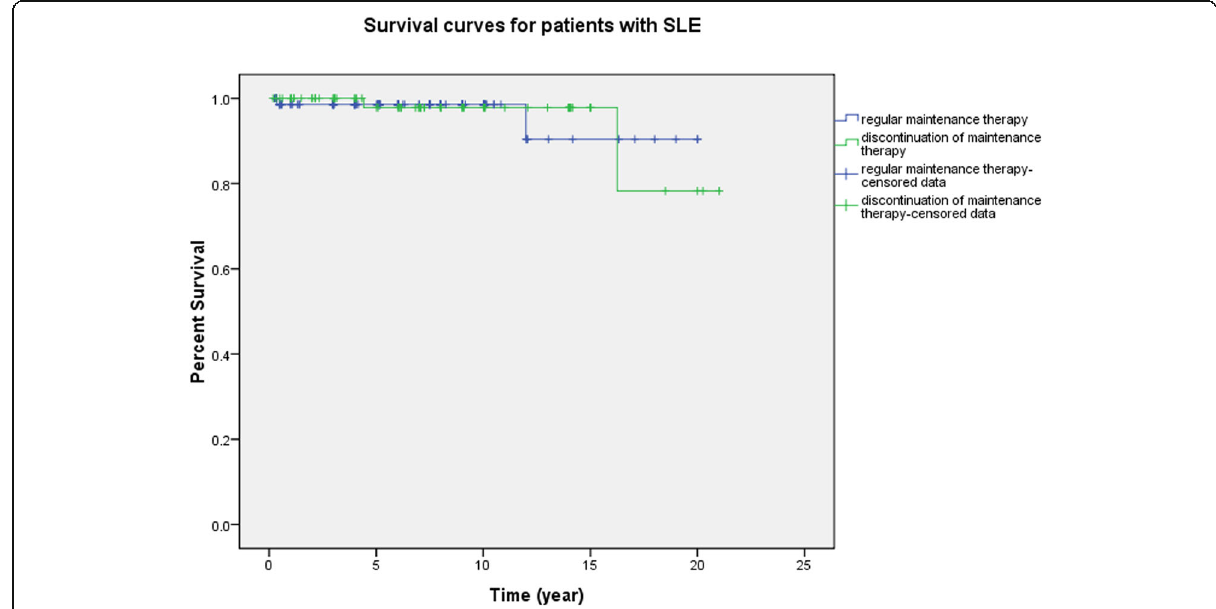
Fig. 1 Survival curves for patients with SLE who discontinued medicine maintenance therapy by themself and with regular medicine maintenance therapy (Log- Rank test P = 0.949)